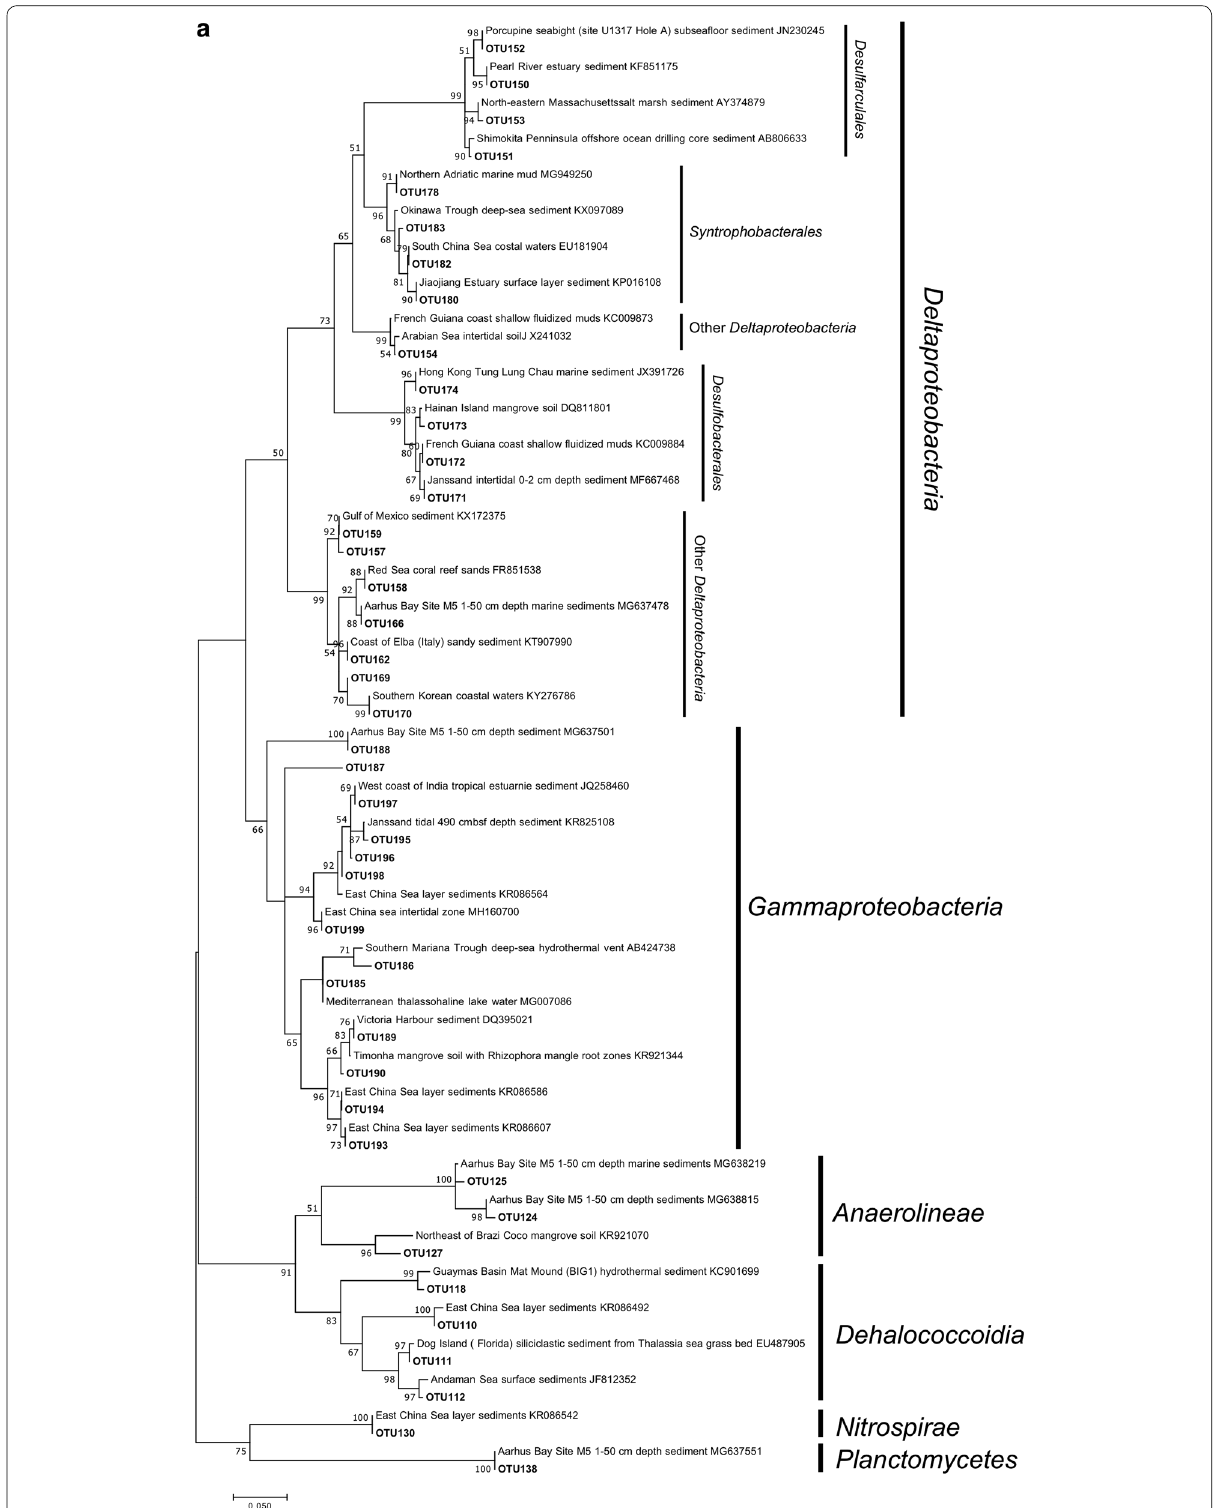
Fig. 6 The maximum likelihood tree of 16S rRNA gene sequences showing the phylogenetic affiliations of the bacterial ( a ) and archaeal ( b ) OTUs significantly related to geochemical factors (Spearman, ρ > 0.65, P < 0.0001). MHVG marine hydrothermal vent group. MBGD marine benthic group